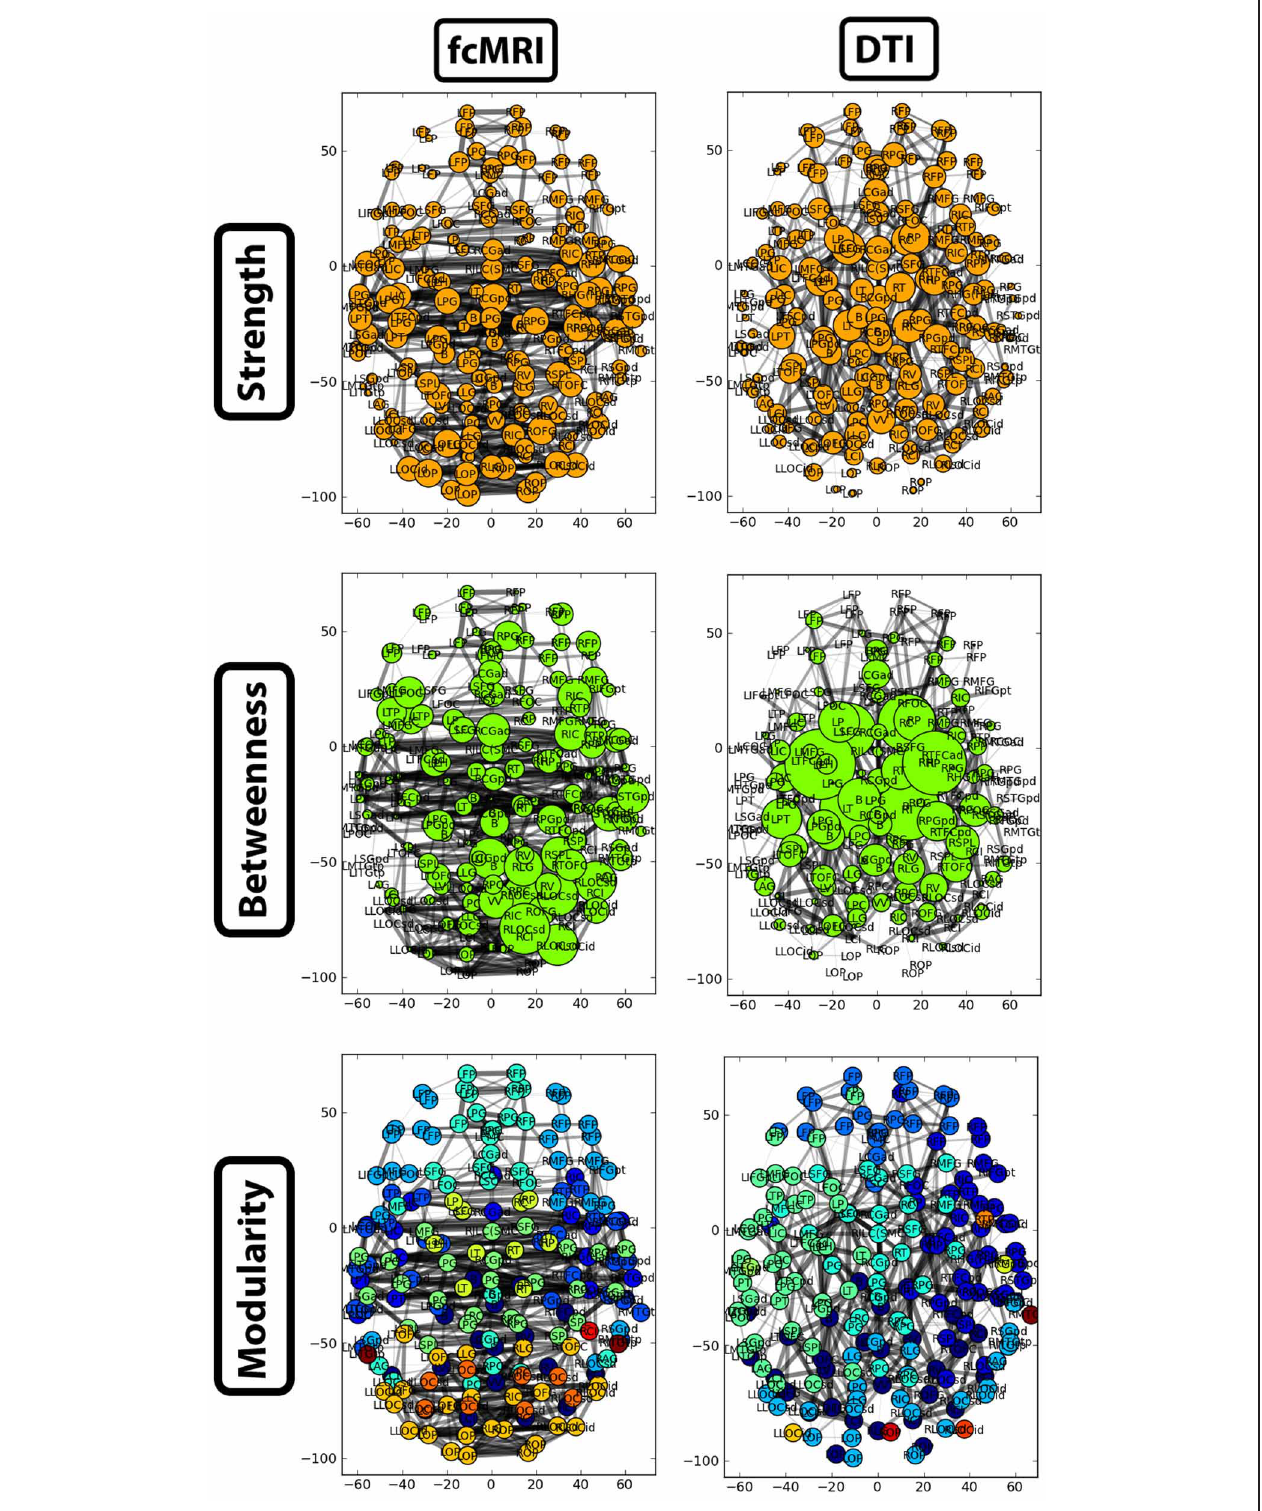
FIGURE 7 | Two-dimensional network plots from fcMRI and DTI group average networks. Networks are viewed from a top/axial view with edge width proportional to connection strength and node radius/color related to the given network measure. For each network, the top 4% of weighted edges